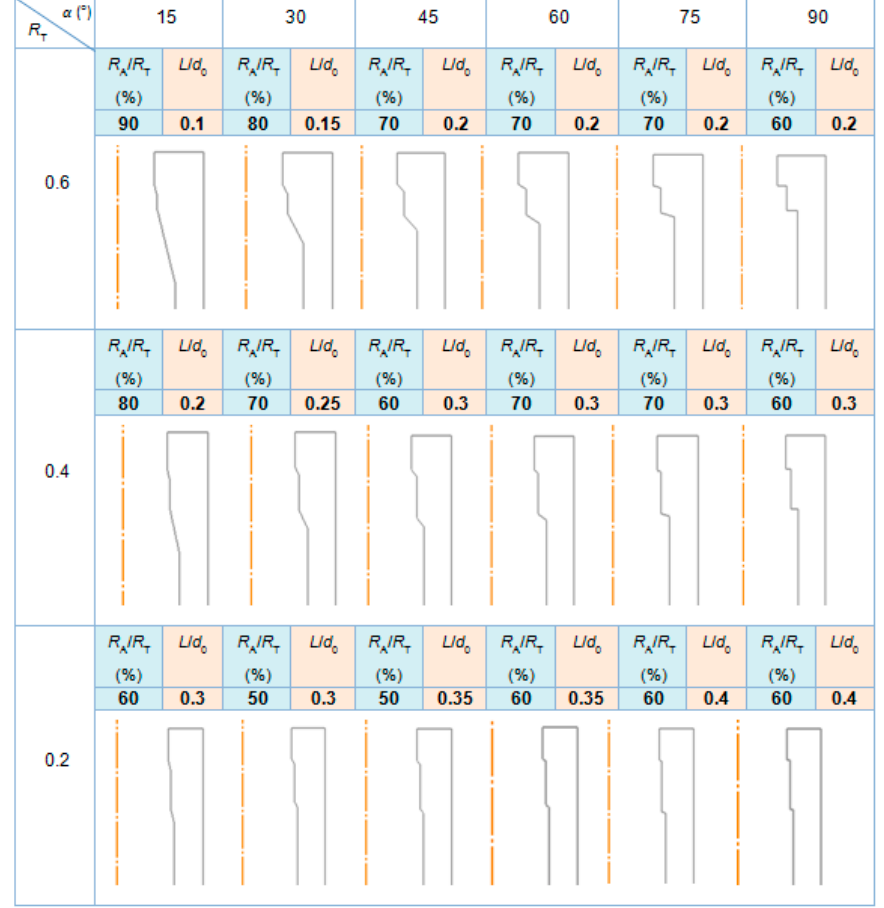
Figure 15. Summary of the best configurations of double-pass dies in cold extrusion of dual-phase steel DP800.